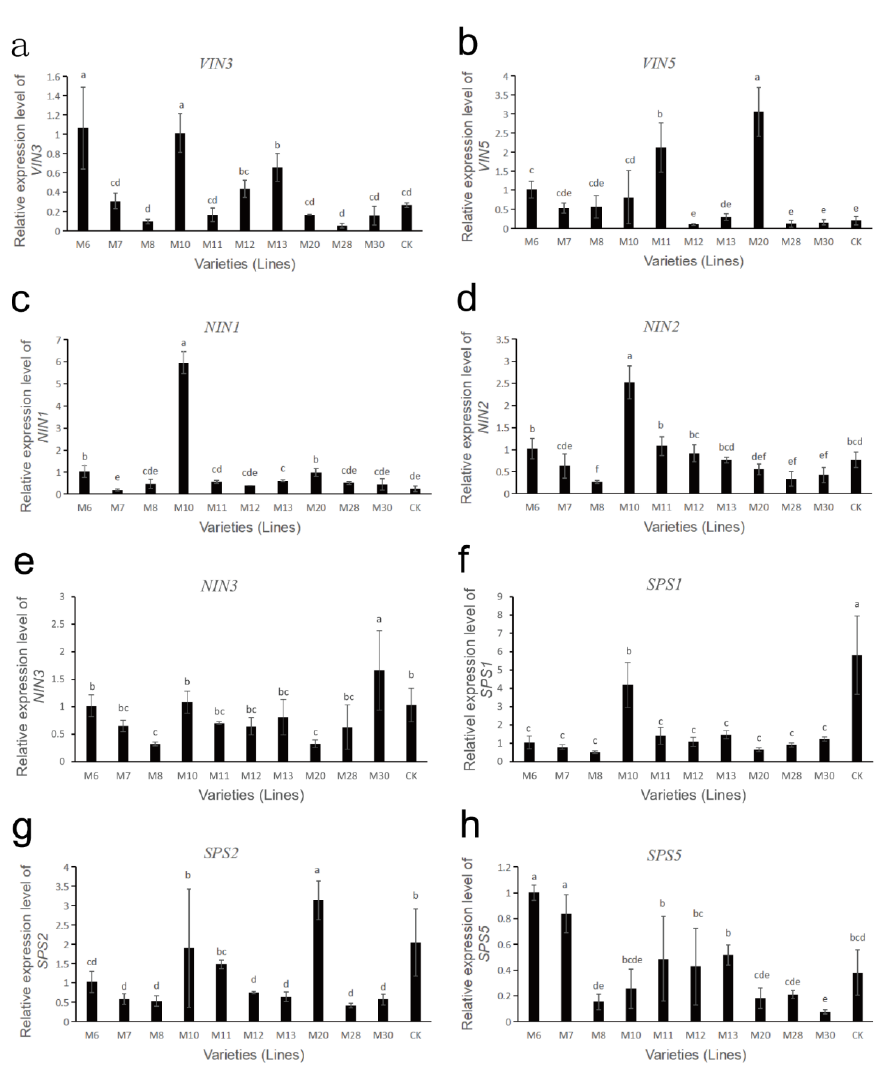
Figure 6. Expression analysis of sucrose metabolism-related enzyme genes in wild A. eriantha of different varieties (lines) at the soft ripening stage, including VIN3 ( a ), VIN5 ( b ), NIN1 ( c ), NIN2 ( d ), NIN3 ( e ), SPS1 ( f ), SPS2 ( g ) and SPS5 ( h ). The different letters in each figure indicate significant differences ( p < 0.05), and the same letters indicate no significant difference ( p > 0.05).